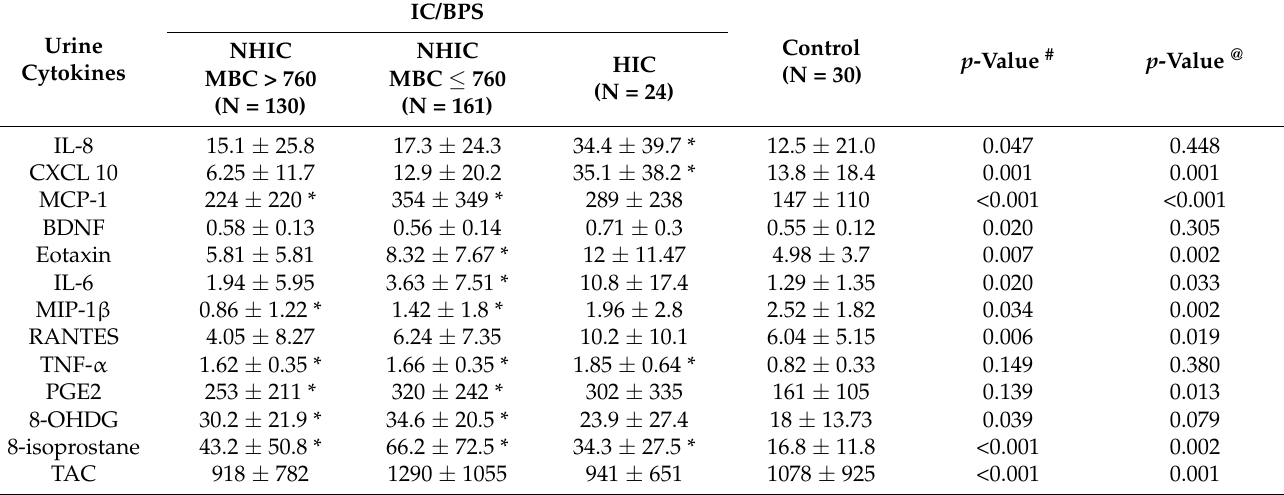
Table 2. Comparison of urine levels of biomarkers among IC/BPS subtypes with different maximal bladder capacities.